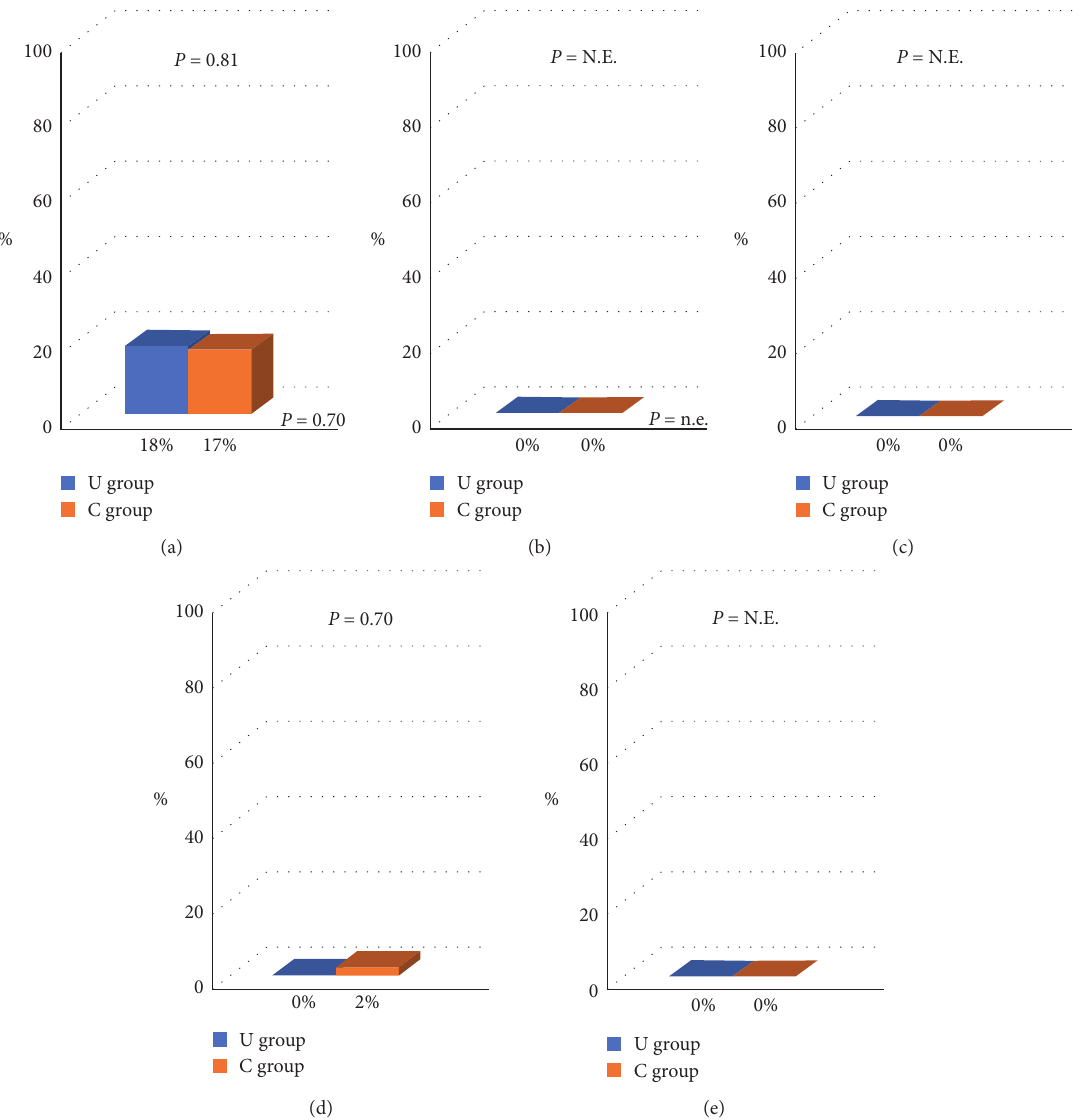
Figure 5: Complication rate. RAO: radial artery occlusion. (a) Access-site ecchymosis. (b) Minor bleeding. (c) Major bleeding. (d) Nerve disorder. (e)